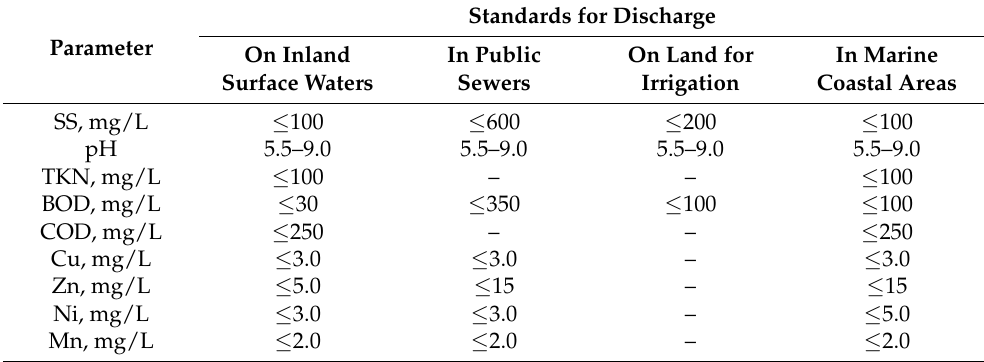
Table 1. Indian standards for the discharge of wastewater